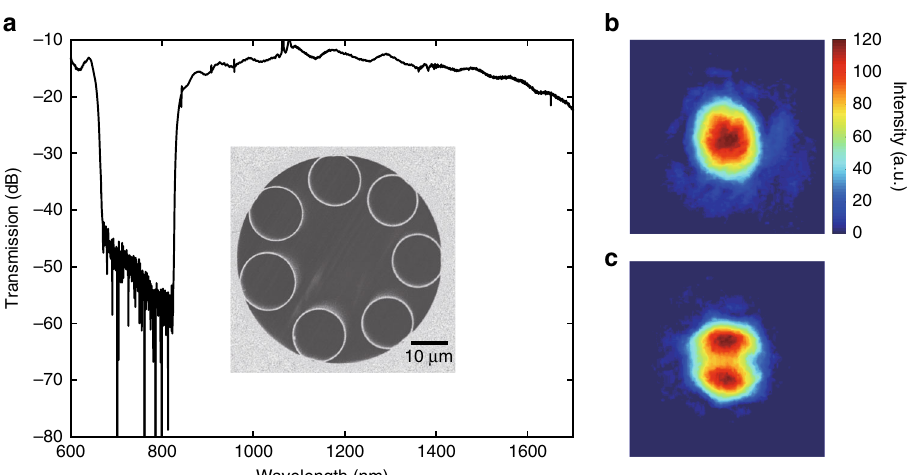
Fig. 1 The HCF. a Cross-section and spectral transmission of a 4-m-long SR-AR-HCF. The HCF has a silica outer cladding with inner diameter of ~56 μ m, seven capillary rings with diameter of ~ 14 μ m and thickness of ~370 nm, giving an inscribed air core with diameter of ~28 μ m. b , c Intensity pro fi les of b the fundamental mode LP 01 and c a mix of the LP 01 and second-order LP 11 modes at 1550 nm, viewed at the output of a 1.5-m-long SR-AR-HCF. The orientations of the mode patterns are stable and do not vary with small perturbation applied to the HCF. By varying launch condition, another LP 11 mode (not shown) with lobe-orientation orthogonal to the one shown in this fi gure can be excited, we called the two LP 11 modes LP 11a and LP 11b , respectively. No other higher- order modes are observed when input launching condition is varied. The calculated fi eld distributions of the LP 01 and LP 11 modes are presented in Supplementary Note 1. The effective RI difference between the LP 01 and LP 11 modes is ~1.2 × 10 − 3